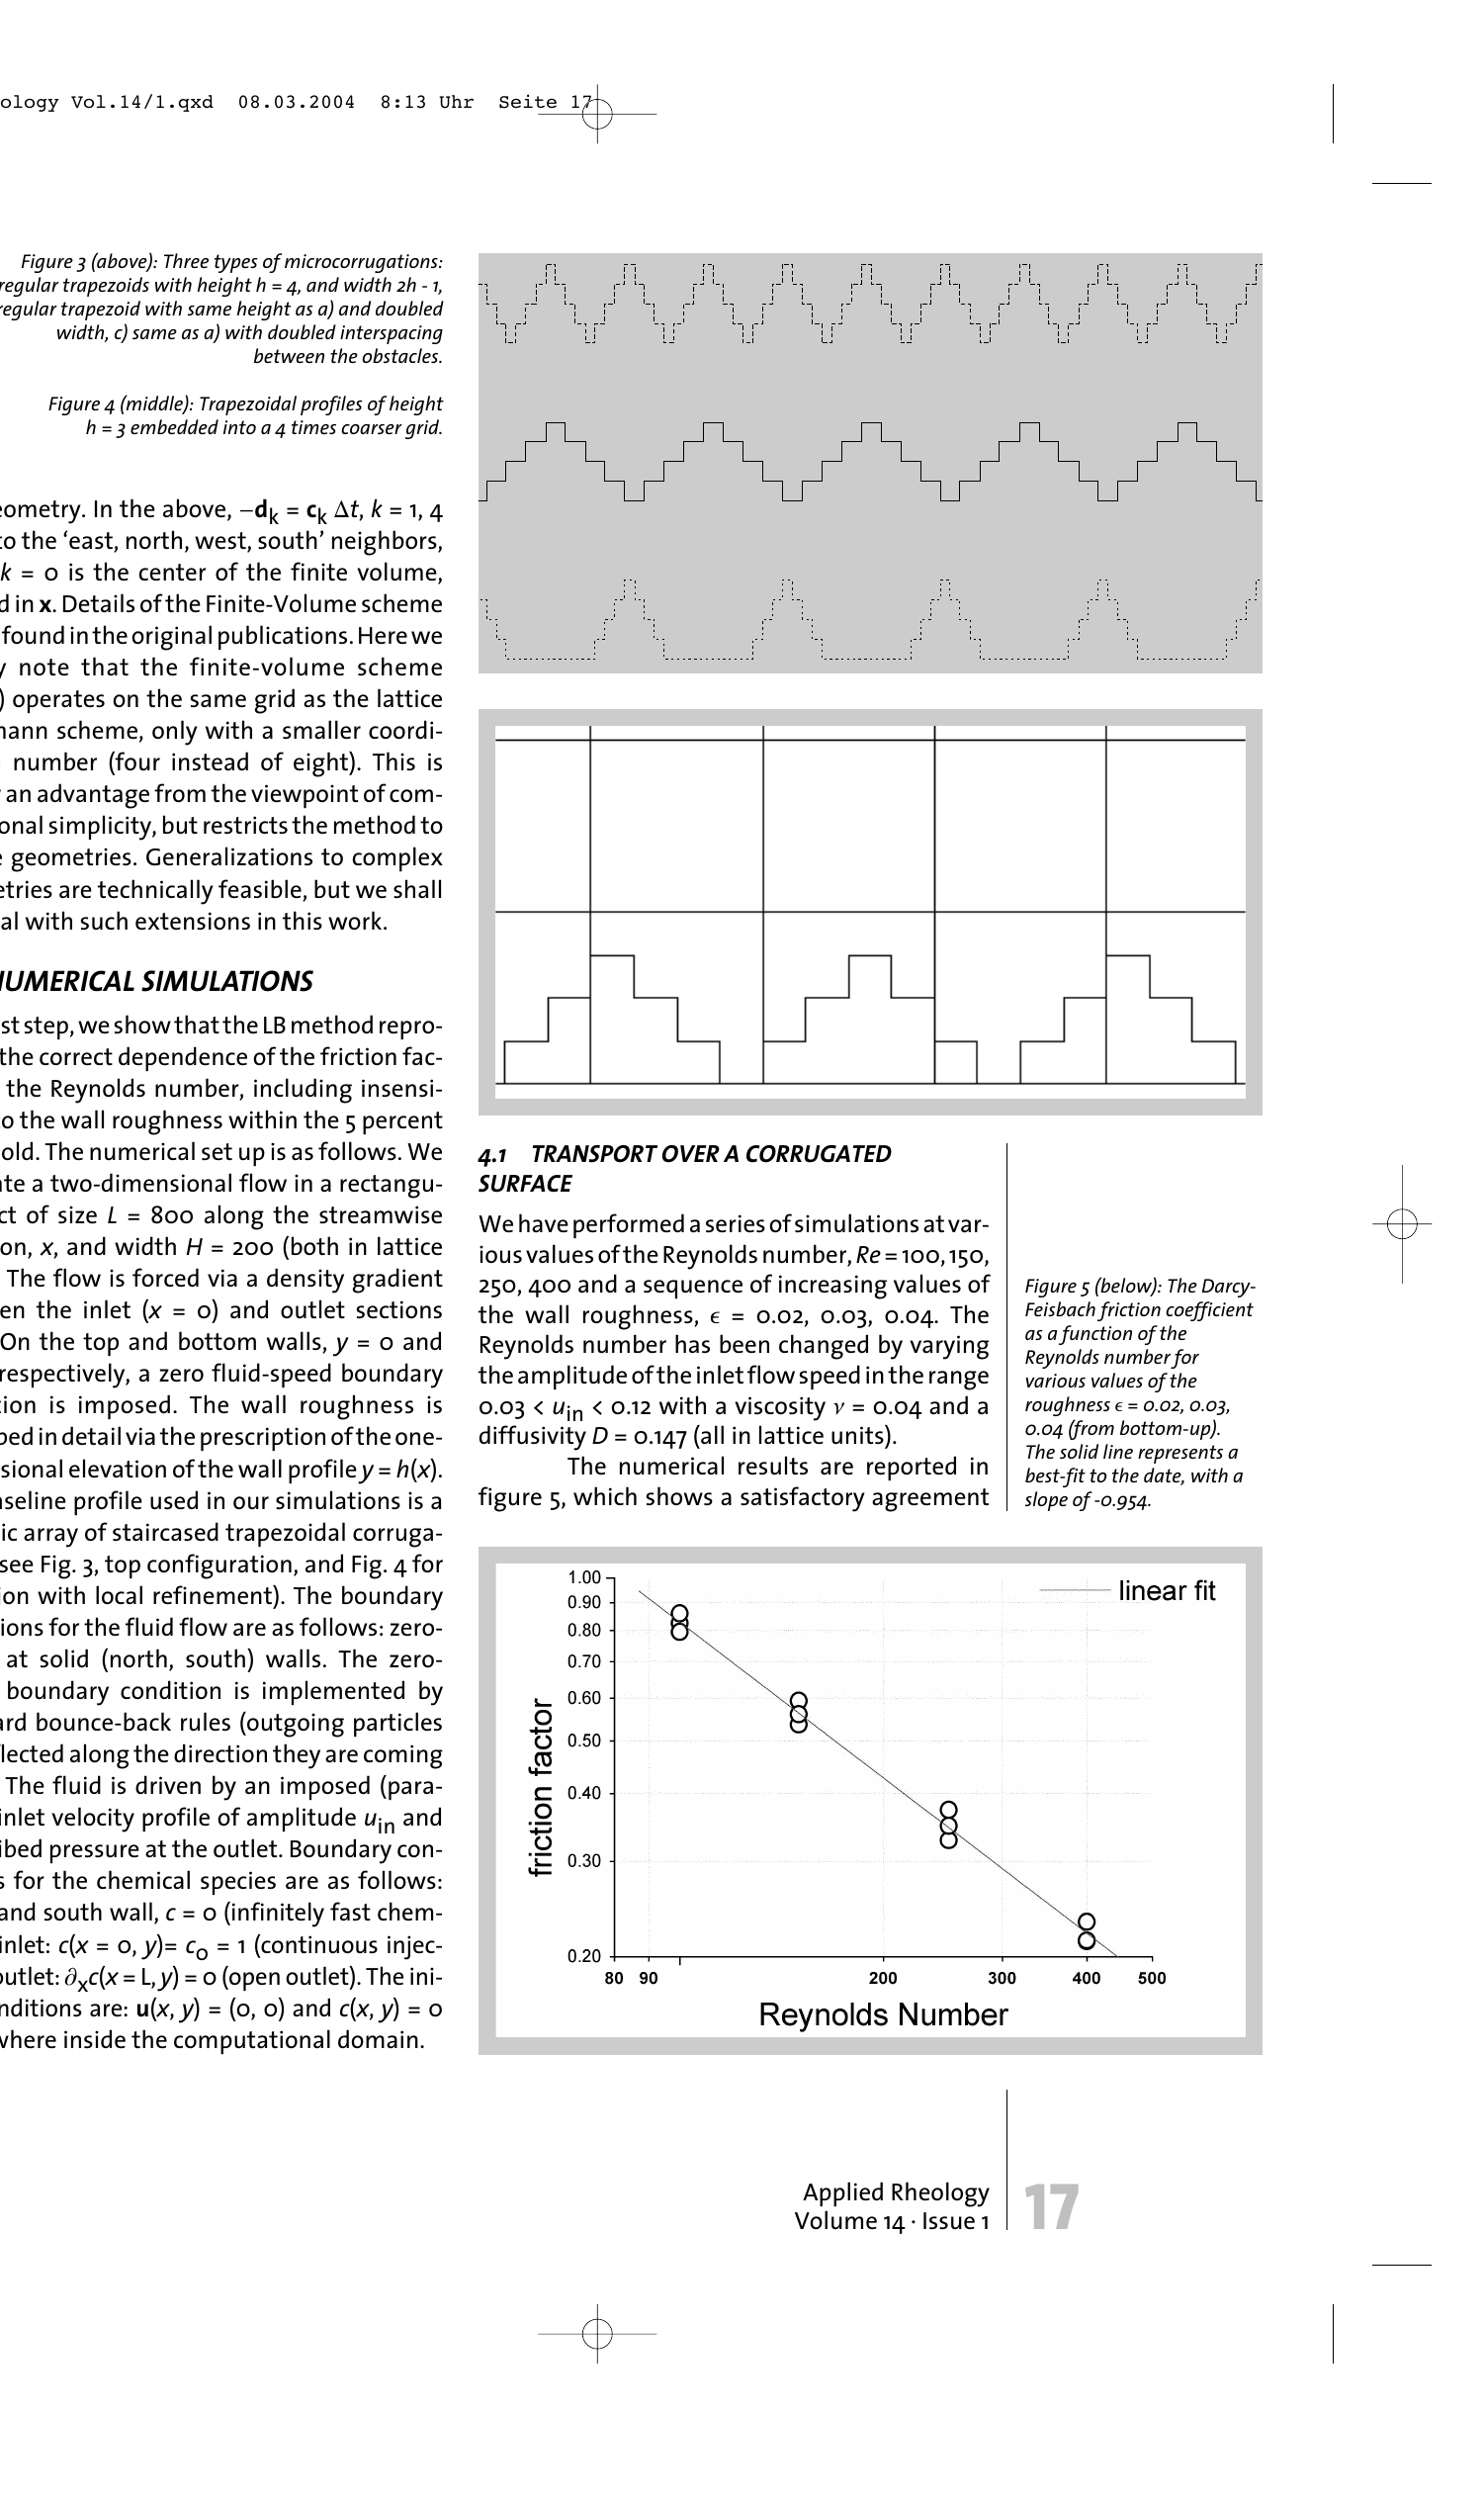
Applied Rheology Vol.14/1.qxd 08.03.2004 8:13 Uhr Seite